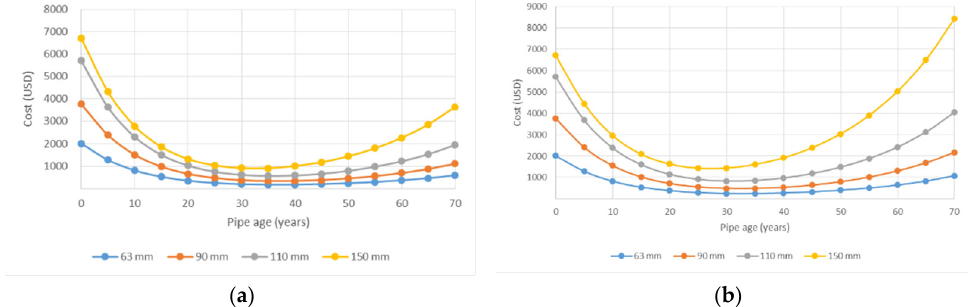
Figure 12. LCC curves of various diameters. ( a ) MCMC estimation; ( b ) ML estimation.